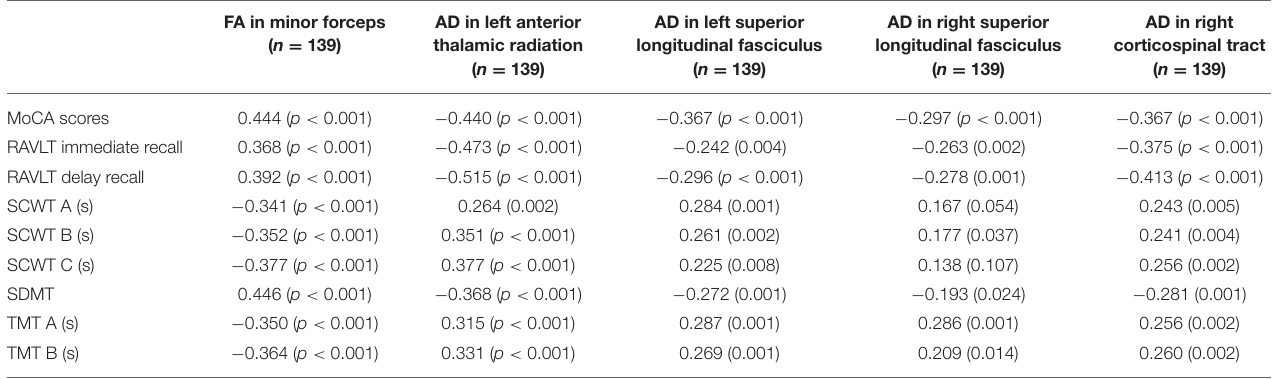
TABLE 2 | Correlation analysis between DTI parameter metrics and cognition scale (1).